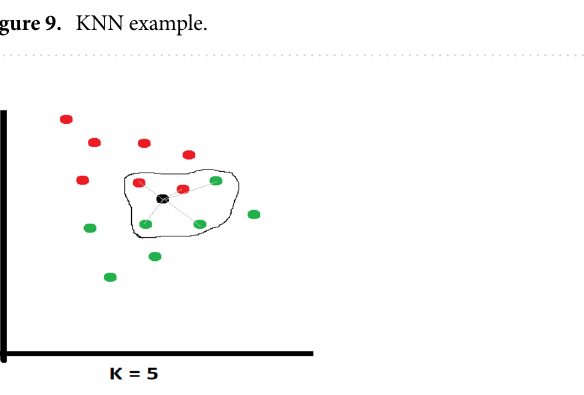
Figure 9. KNN example.